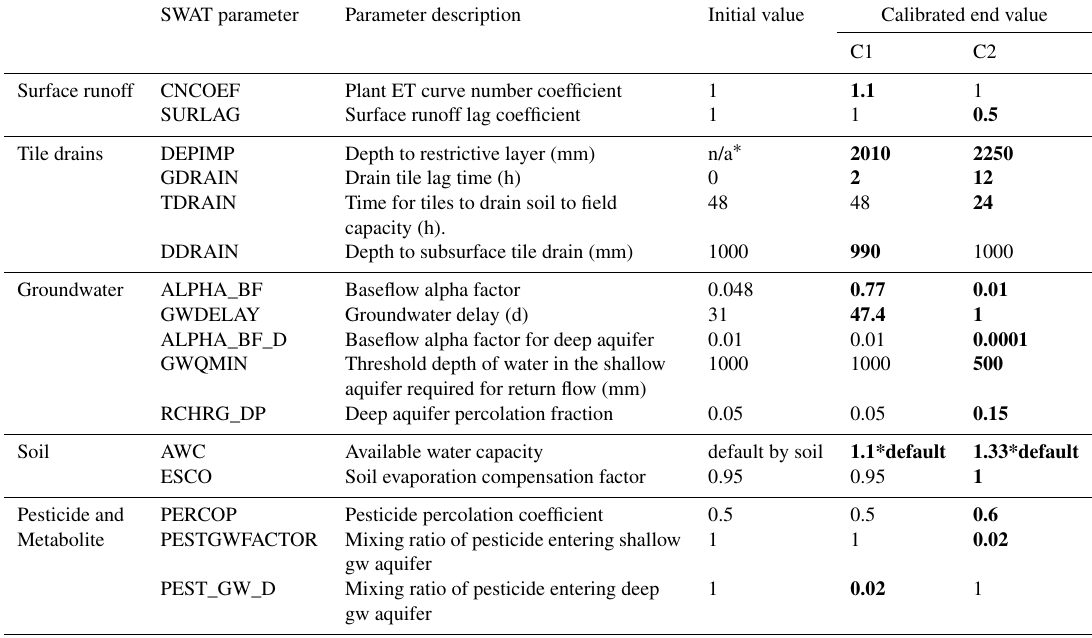
Table 2. Calibration parameters with initial value and calibrated end value (changed values in